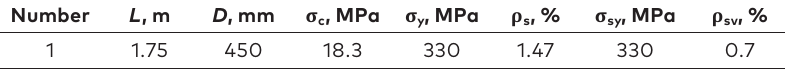
Table 1. Properties of cross-section of the simulated bridge